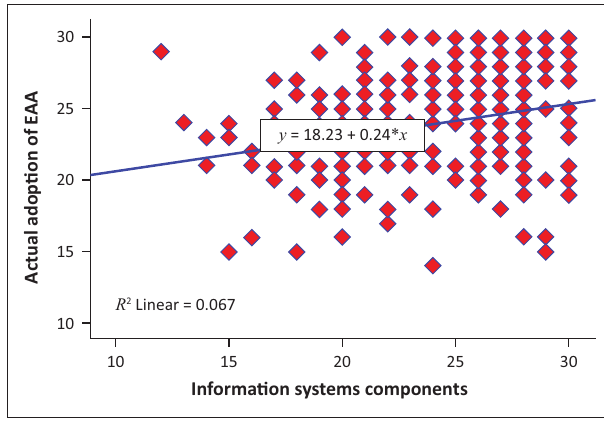
FIGURE 4: Linear regression model on information systems components and actual adoption of EAA slope (+0.24) of good results gives the average variation in the y variable (in this case, actual adoption of EAA) for a variation in the x variable (information systems components) on one unit, where R 2 = 0.067.